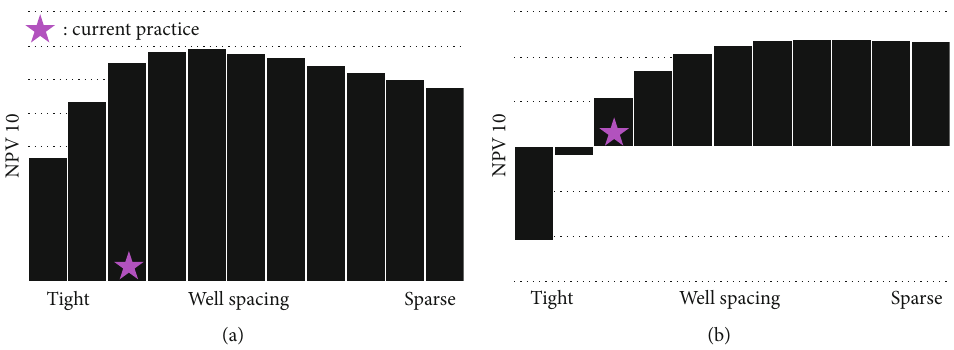
Figure 18: NPV10 per section at di ff erent commodity prices: (a) commodity price 20% higher than the assumption and (b) commodity price 20% lower than the